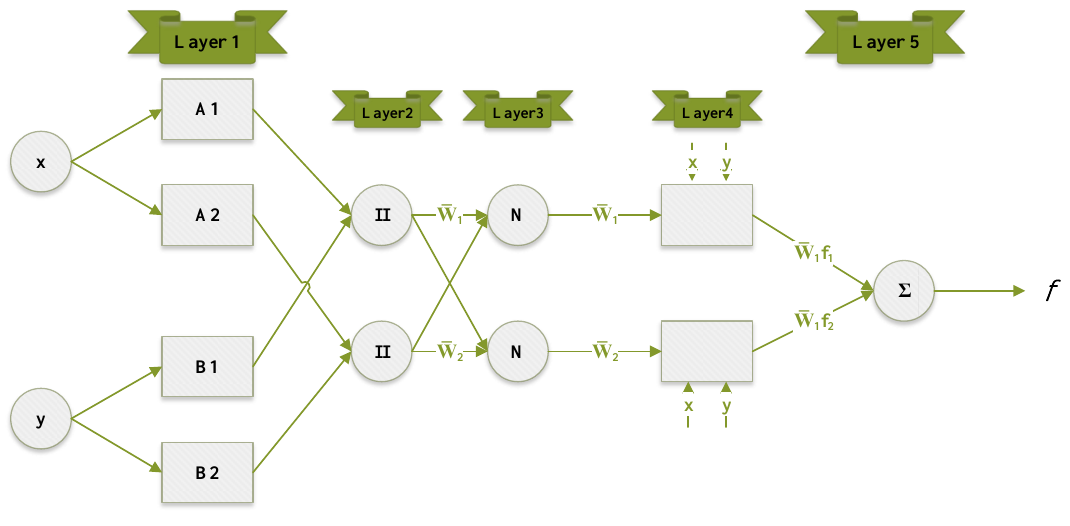
Figure 5. A basic architecture of ANFIS